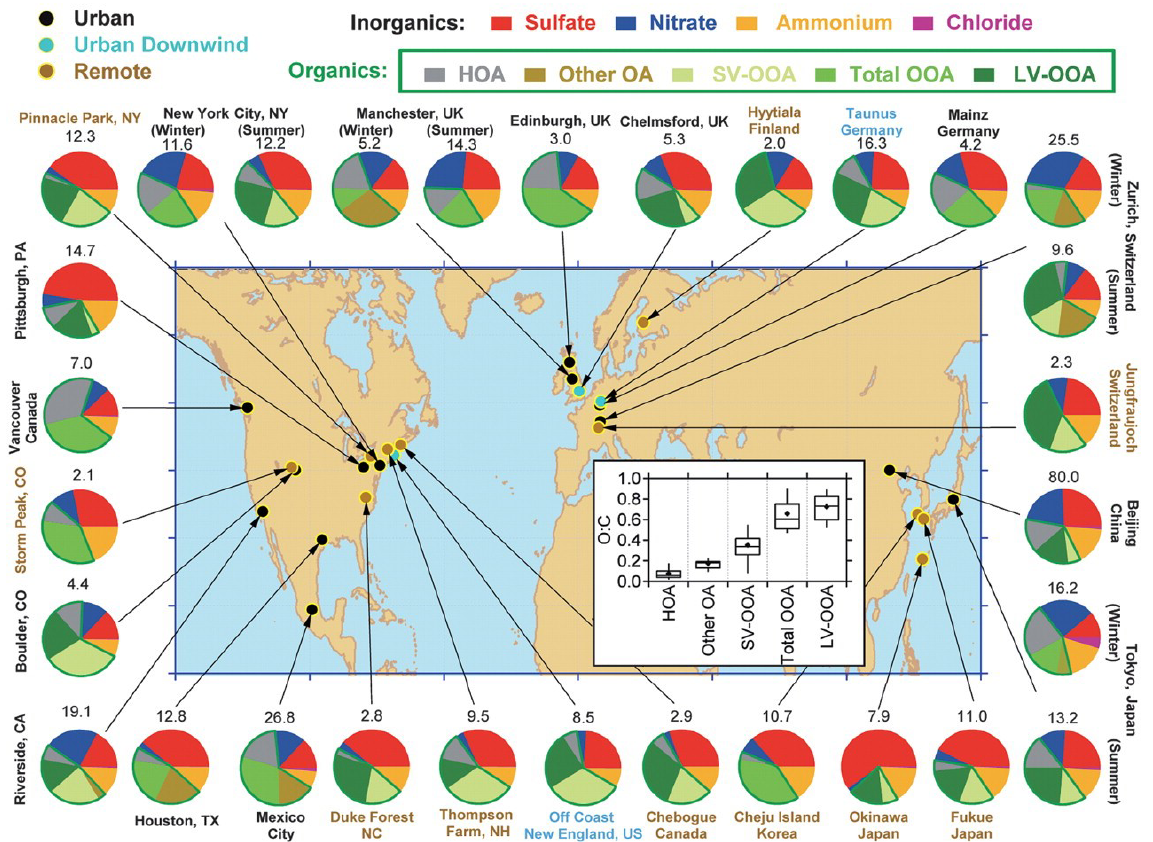
Figure 6. Total mass concentration (in micrograms per cubic metre) and mass fractions of nonrefractory inorganic species and organic components in submicrometer aerosol particles measured with the AMS at multiple surface locations in the Northern Hemisphere at mid- latitudes. The organic components were obtained with FA-AMS methods (Zhang et al., 2007). In some studies, the FA-AMS methods identified one OOA factor, whereas in other locations, two types, SV-OOA and LV-OOA, were identified. HOA is a surrogate for urban primary OA, and “other OA” includes primary OAs other than HOA that have been identified in several studies, including BBOA. Inset: distributions of O : C for the OA components identified at the different sites (Jimenez et al., 2009).